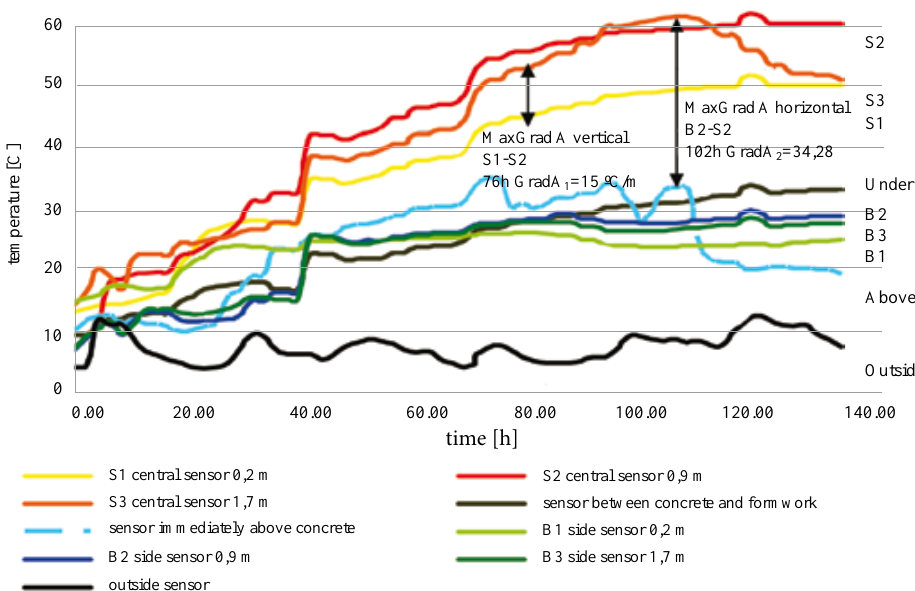
Fig. 3. Temperature distribution in the beginning phase of concrete bonding: